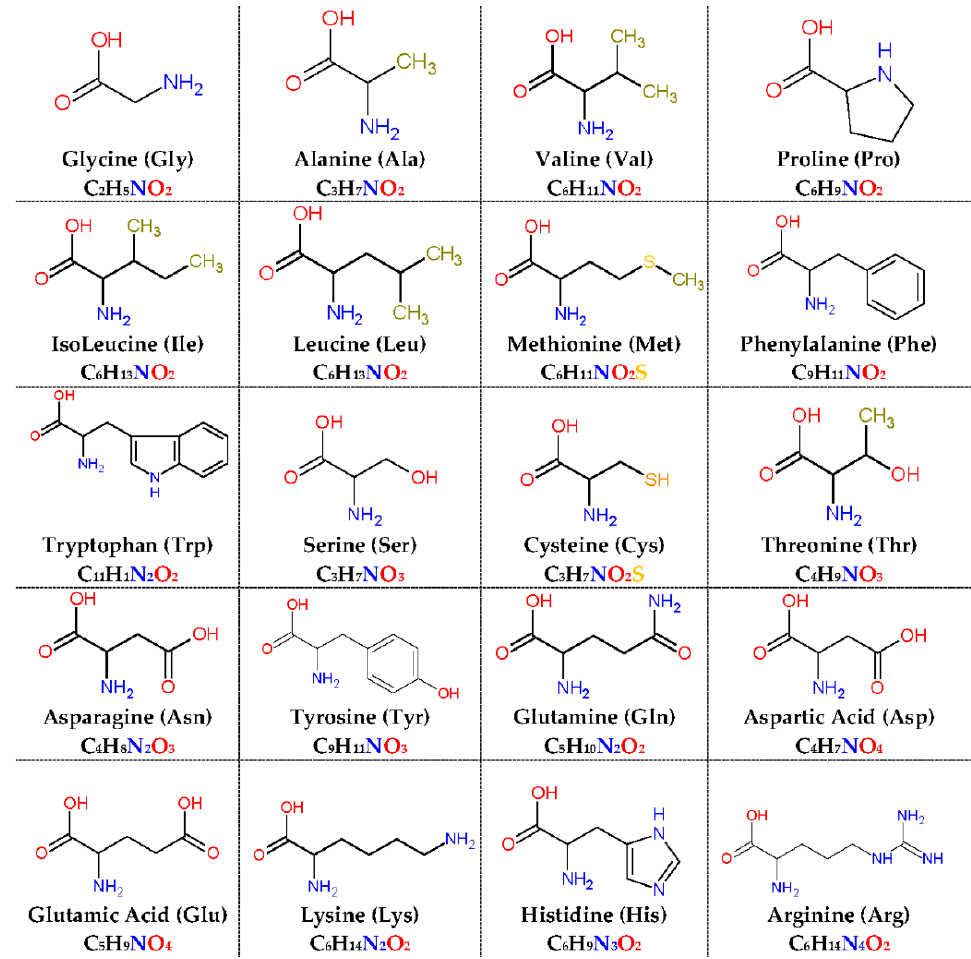
Figure 1. Molecular structure of the investigated L-amino acids.